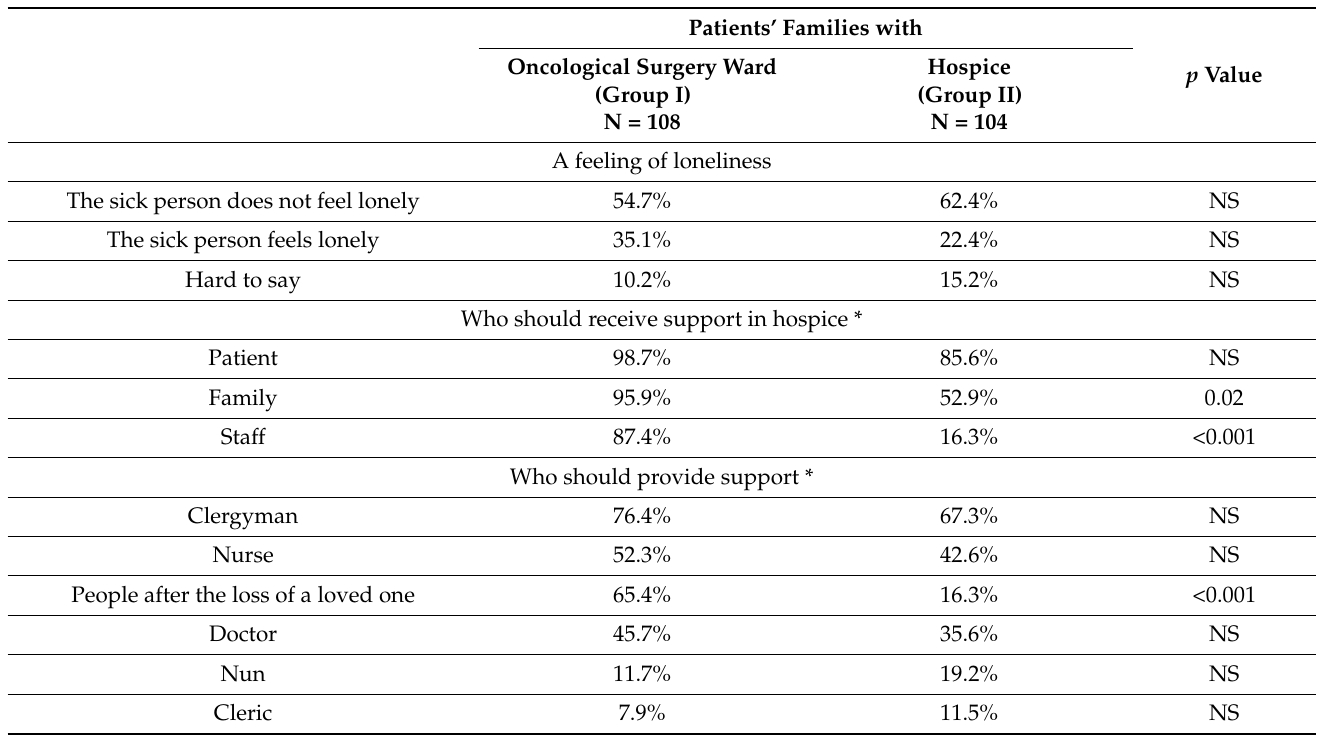
Table 10. The respondents’ opinions on the patient’s feeling of loneliness and the expected support in hospice.